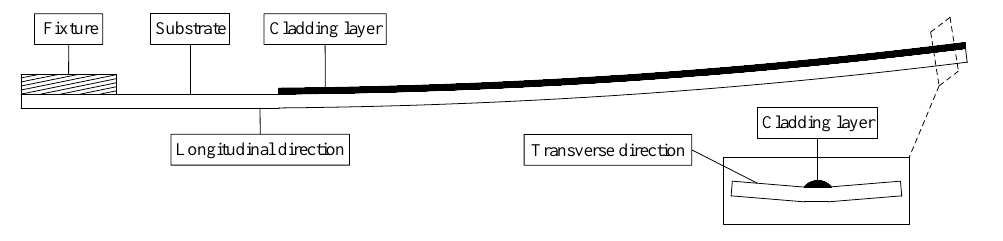
Figure 3. Diagram of sheet deformation.